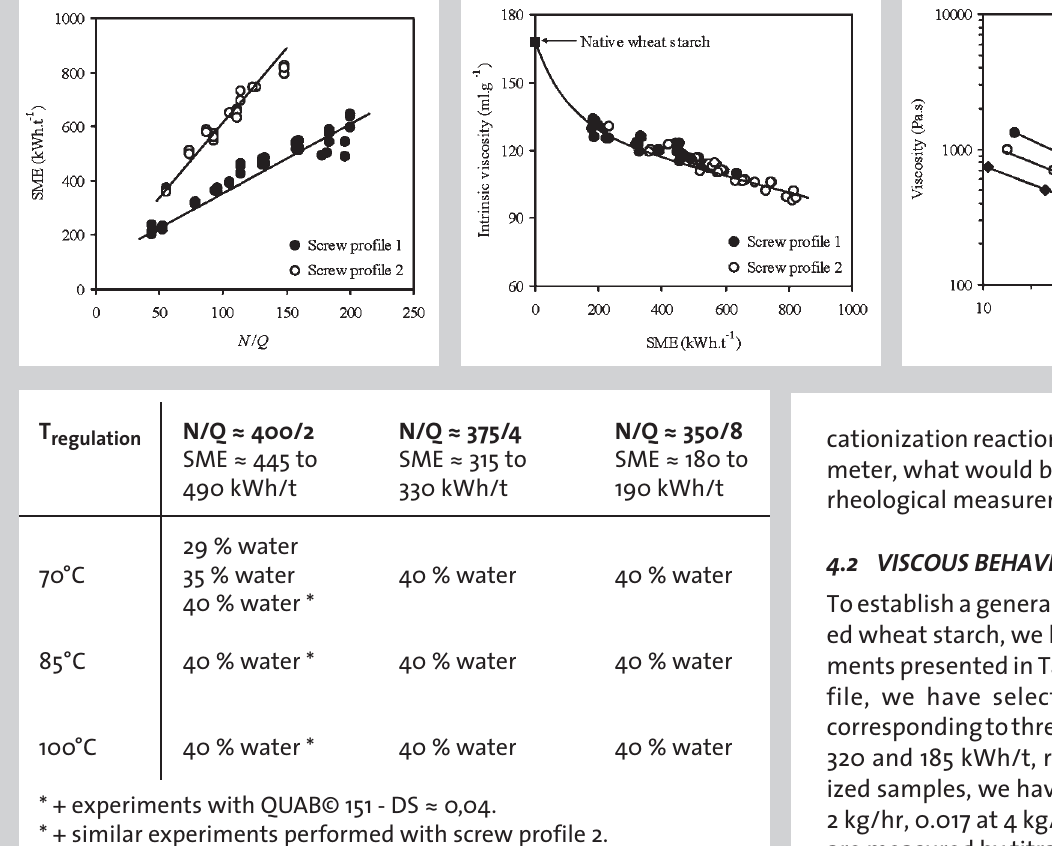
Figure 3 (left): Variation of the specific mechanical energy (SME) with the N/Q ratio, for sam- ples with and without reac- tion. Figure 4 (middle): Variation of intrinsic viscosi- ty with specific mechanical energy (SME), for samples with and without reaction. Figure 5 (right): Viscosity curves at constant SME (40% water) for three different temperatures. The values indicated on the curves are the values mea- sured at die exit. The values in the legend are the imposed barrel tempera- tures. Table 1: Experiments performed with screw profile (water content is expressed on starch dry basis). N is expressed in rpm, Q in